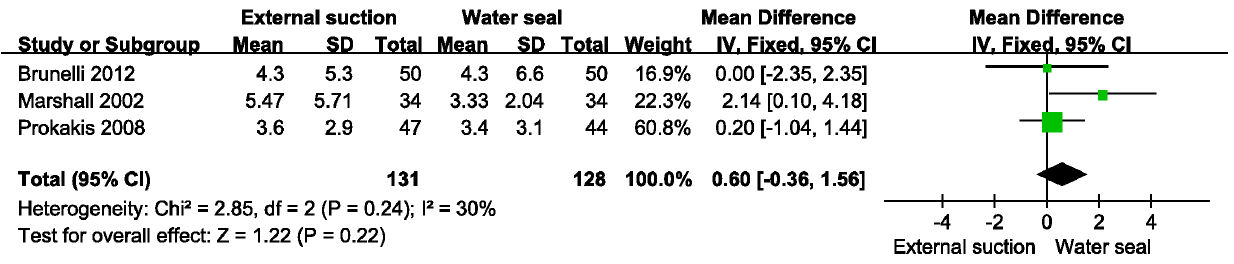
Figure 4. Meta-analysis of external suction versus water seal on the time of drainage. IV, inverse variance method.